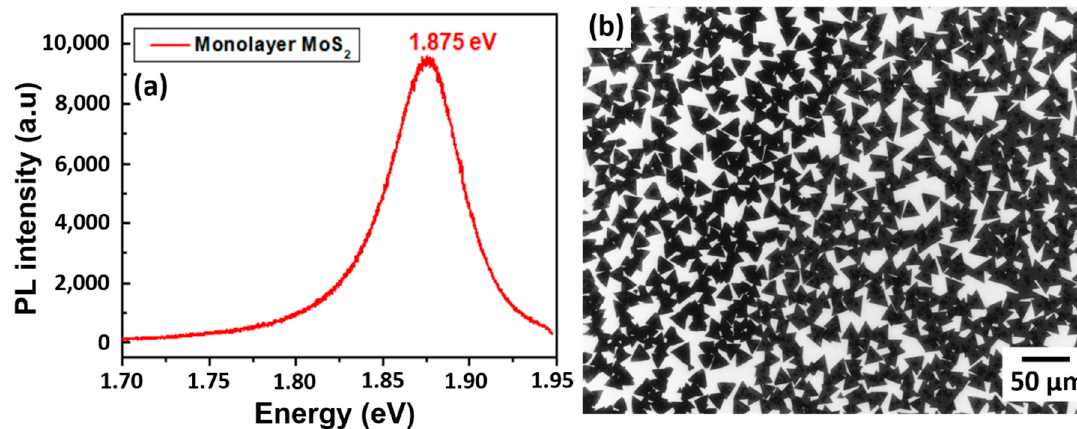
Figure 7. Characterization of monolayer MoS 2 nanosheets: ( a ) photoluminescence (PL) spectrum showing a strong emission for a monolayer MoS 2 and ( b ) SEM image of isolated highly dense MoS 2 domains on SiO 2 / Si substrate.